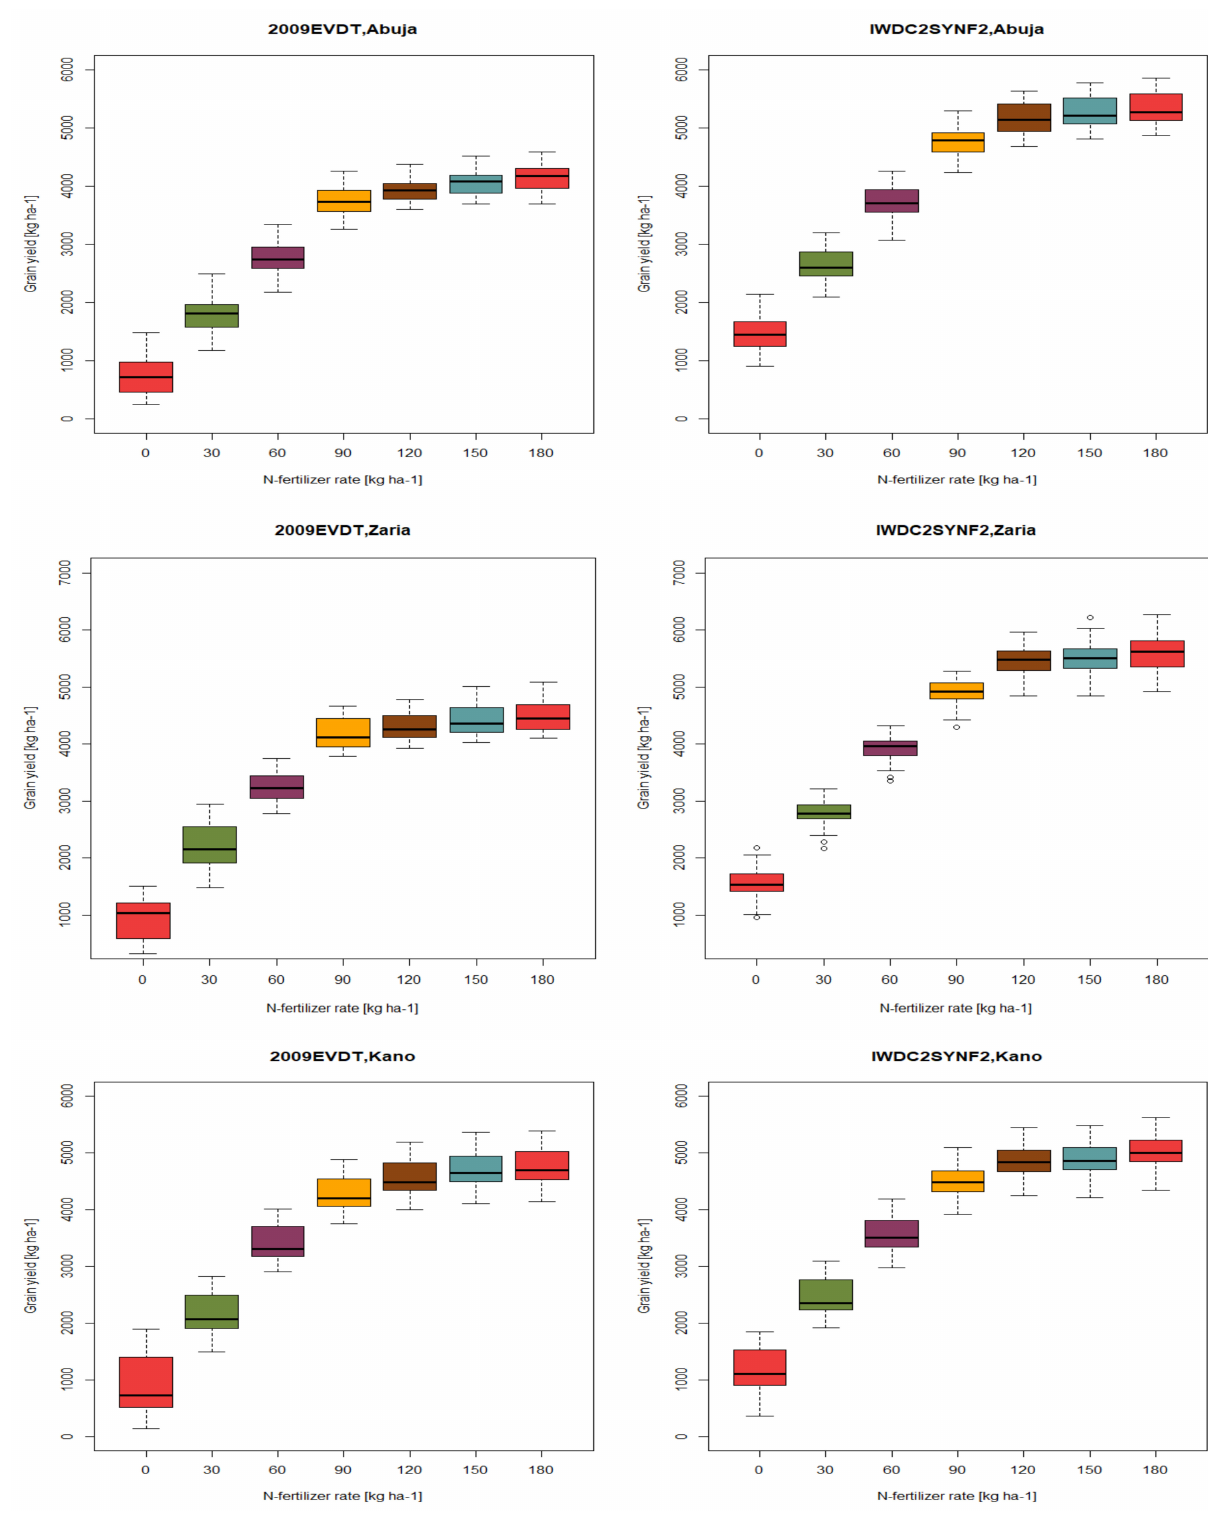
Figure 4. Box plot of 31 years (1985–2015) simulated grain yield for 2009EVDT and IWDC2SYNF2 applied under varying N–fertilizer in Abuja, Zaria and Kano respectively. The boundary of the box closest to zero indicates the 25th percentile; a line within the box marks the median, and the upper boundary of the box indicates the 75th percentile. Whiskers above and below the box indicate the 95th and 5th